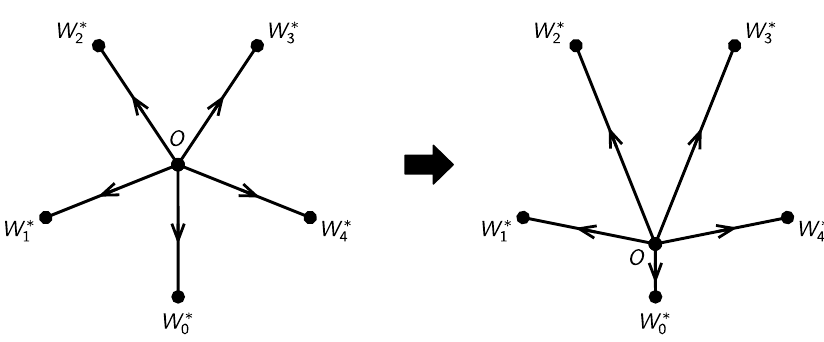
Figure 7 . By sending (cid:11) ! W (cid:3)